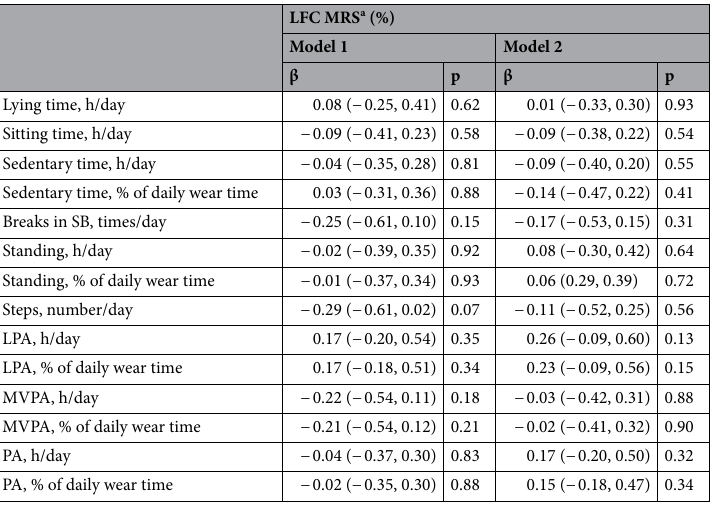
Table 4. Age-, sex- and body fat % -adjusted linear mixed regression estimates (standardized β coefficients (95% CI)) between MRS-measured LFC, sedentary behavior and physical activity. Model 1 adjusted for age and sex. Model 2 adjusted for age, sex and body fat % LFC liver fat content, LPA light physical activity, MUFA monounsaturated fatty acids, MRS magnetic resonance spectroscopy, MVPA moderate to vigorous physical activity, PA physical activity (LPA and MVPA together), SB sedentary behaviour (sitting and lying). a log10 transformed